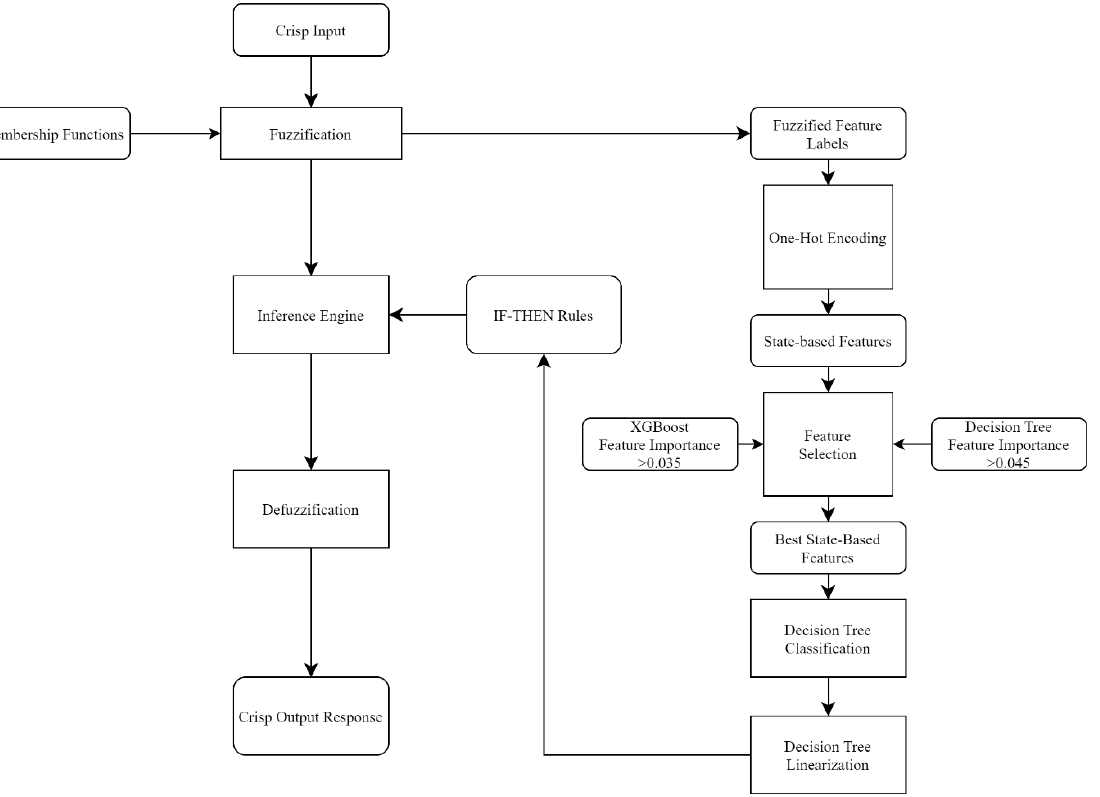
Figure 2. Fuzzy system design for optimal consumption recommendations based on the load profile and weather data.